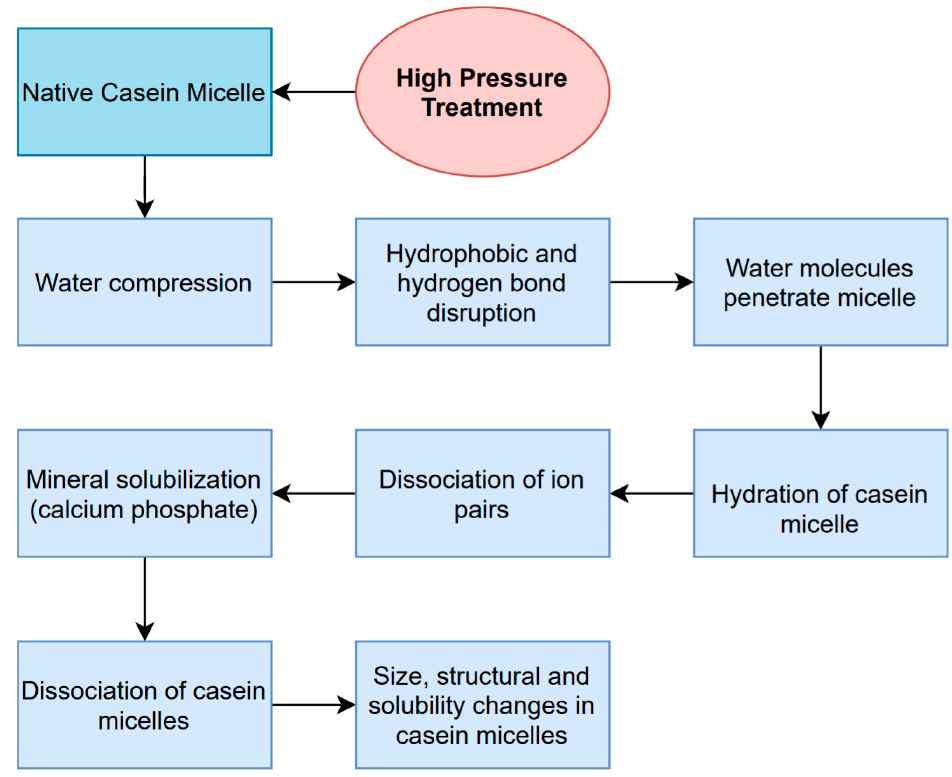
Figure 2. Sequence of effects regarding the denaturation of casein micelles by HPP, adapted from [7,10,39,42,47,48].